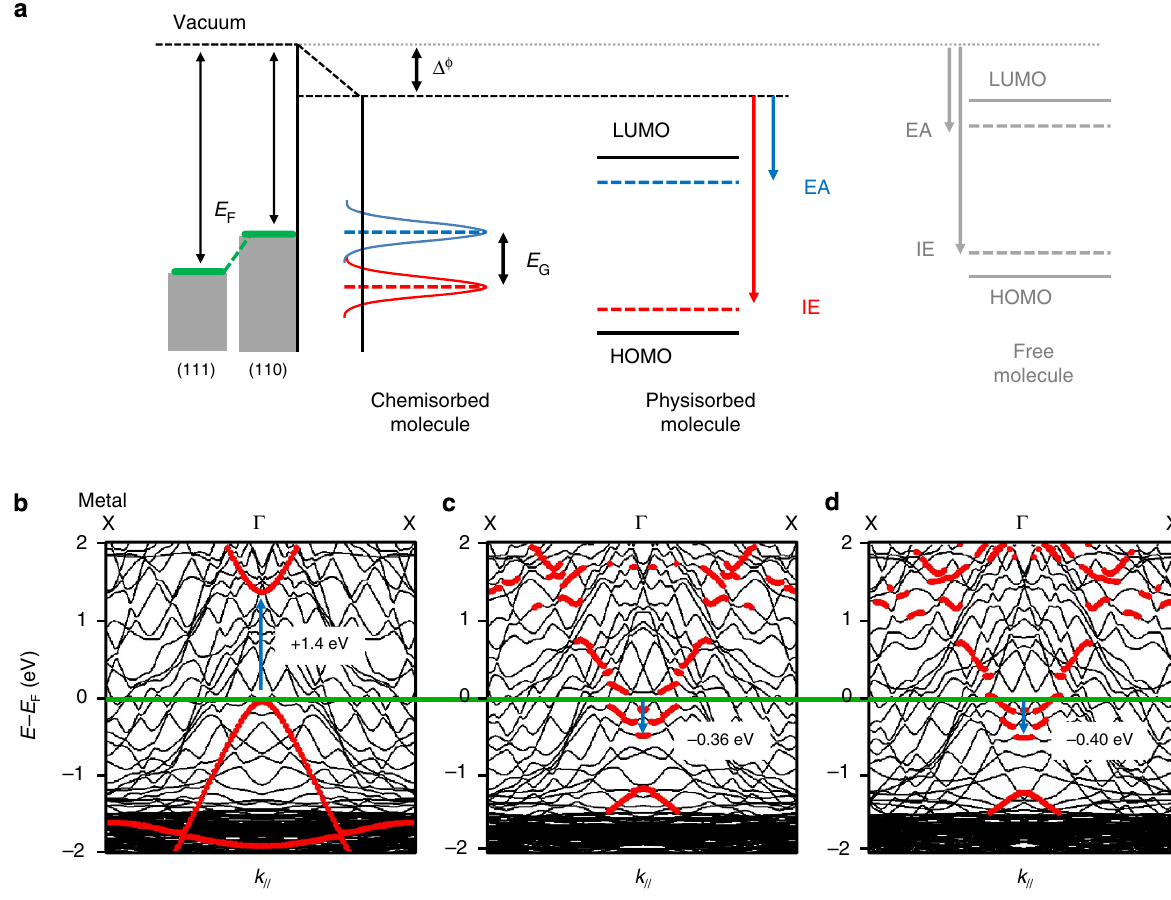
Figure 5 | Impact of the substrate and bromine atoms on electronic properties. ( a ) Schematic representation of energy level alignments and bandgap modifications in organic/metal interfaces. DFT band-structure calculated enlarging the PPP-Cu(110) surface distance to 8Å instead of 2.2Å for the optimized structure ( b ), keeping the surface distance to 2.2Å with ( c ) and without ( d ) Br atoms at surface. Red circles in the band-structure correspond to the projection on the first (molecular) layer with the same arbitrary